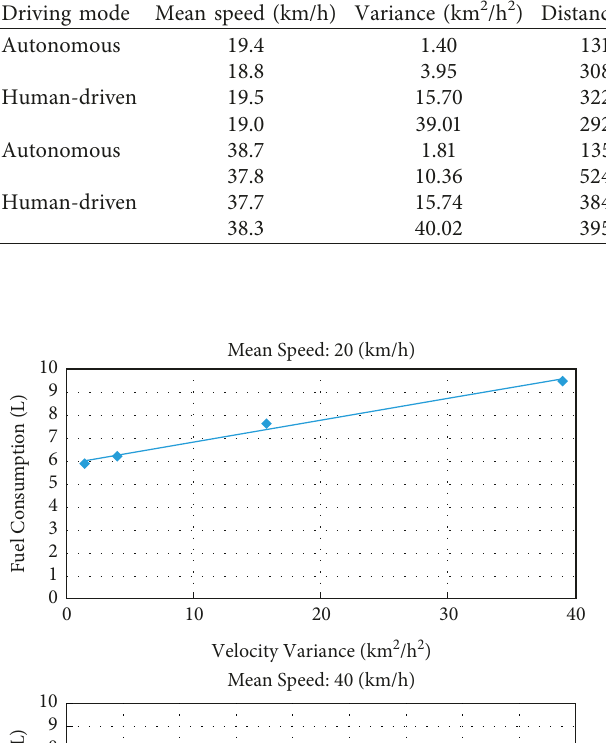
Table 2: Comparison of the effect of different speed fluctuations on fuel consumption under different driving modes. Cycle data